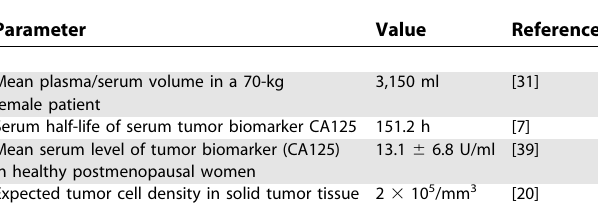
Figure 1. One-Compartment Model